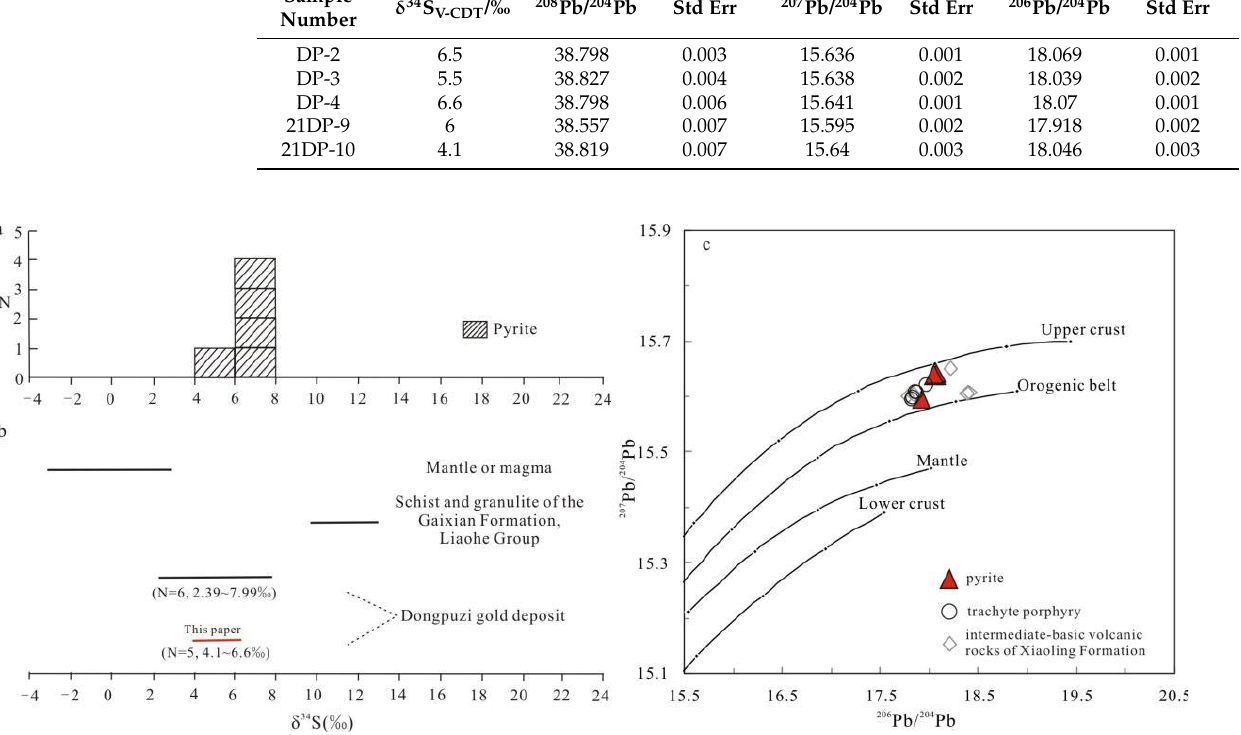
Figure 8. Histogram of the S isotope in the Dongpuzi gold deposit ( a ) and comparison of δ 34 S values between the Dongpuzi deposit and associated geological bodies ( b ). The S isotopic data of Dongpuzi gold deposit are from this paper and [15]; data of the metamorphic rocks of the Gaixian Formation and mantle or deep magma are from [26,27], respectively. The Pb evolution curves for Dongpuzi gold ores ( c ). The data of intermediate-basic rocks of the Xiaoling Formation are from [28].